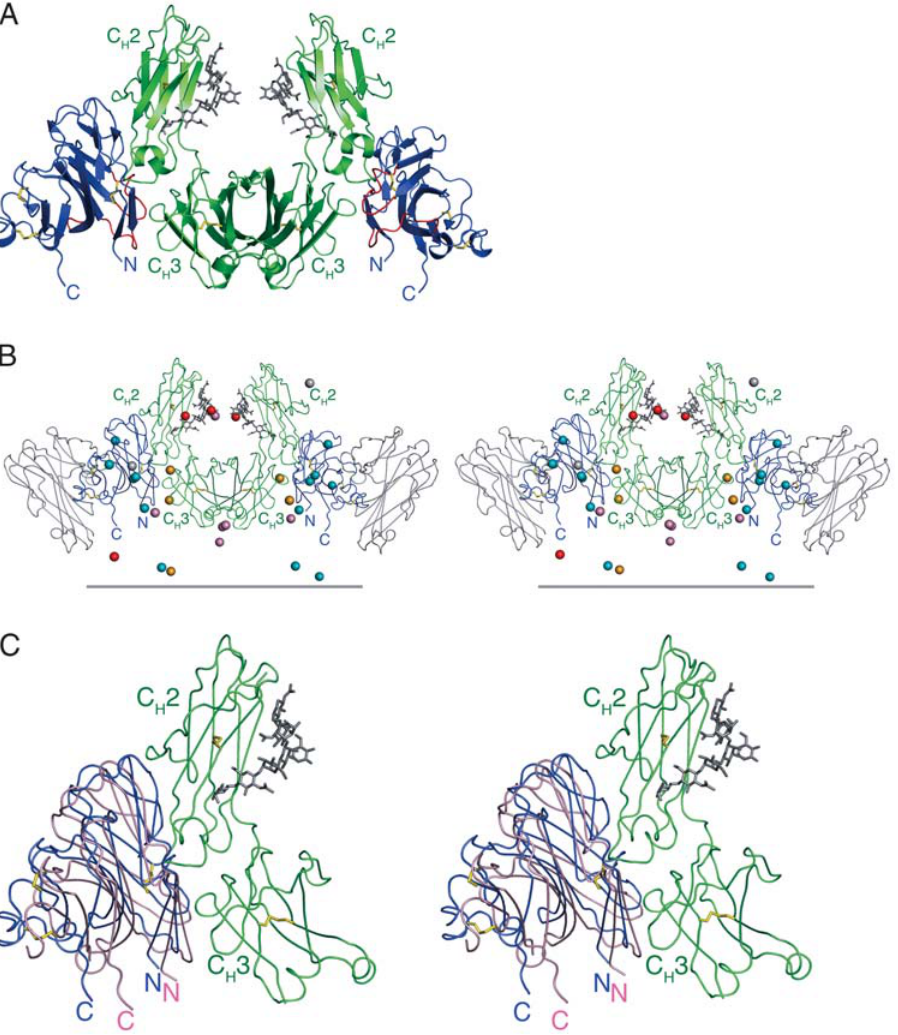
Figure 3. Experimentally Determined and Predicted Structures of CgE Bound to Fc (A) Ribbon diagram of the top molecular replacement solution for a 2:1 CgE/Fc complex. CgE is shown in blue with the CDR loops highlighted in red, and Fc is shown in green. Disulfide bonds are shown in yellow. (B) Stereo view of the location of bound heavy atoms and SeMet residues superimposed on the CgE/Fc model derived by molecular replacement. CgE is blue and Fc is green. The predicted position of the cell membrane (see text) is indicated by a gray line. A CgE molecule related by crystallographic symmetry is shown in gray to demonstrate that the remaining portions of the gE-gI/Fc structure (NgE and gI) cannot occupy this location. The heavy- atoms and SeMet residues are shown as spheres and colored by atom type (gray, mercury; red, tungsten; pink, iridium; orange, platinum; and teal, SeMet). The heavy-atom and SeMet positions identified by Solve [56] were expanded by the crystallographic symmetry operators and translated to the symmetry-equivalent positions that are closet to the CgE/Fc model. (C) Stereo superposition of the crystallographically determined CgE/Fc complex and the complex predicted with RosettaDock [34] using the structures of CgE and Fc. A half complex (one CgE and one chain of the Fc dimer) is shown with Fc in green, the CgE as positioned in the crystal structure in blue, and the CgE as positioned by the docking prediction in pink. The root mean square deviation between the C a atoms of the Rosetta-positioned CgE molecule and each of the CgE molecules in the molecular replacement solution is 3.9 A˚, with the alignment being the best in the regions of CgE that are closest to the CgE/Fc interface and poorest in the regions that are more distant from the binding site. DOI: 10.1371/journal.pbio.0040148.g003